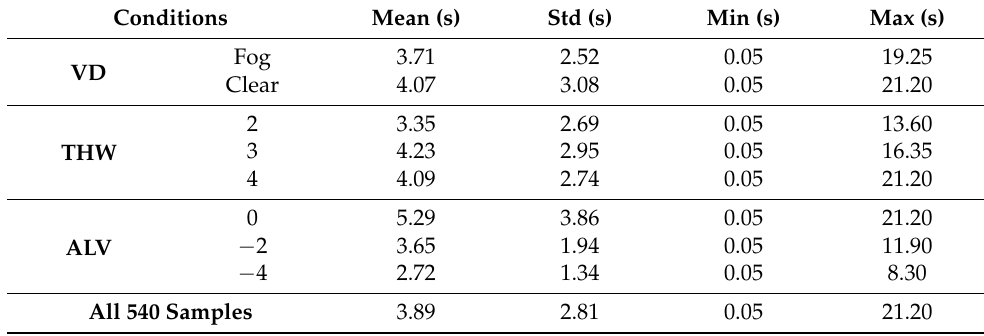
Table 4. Summary of the takeover control time.